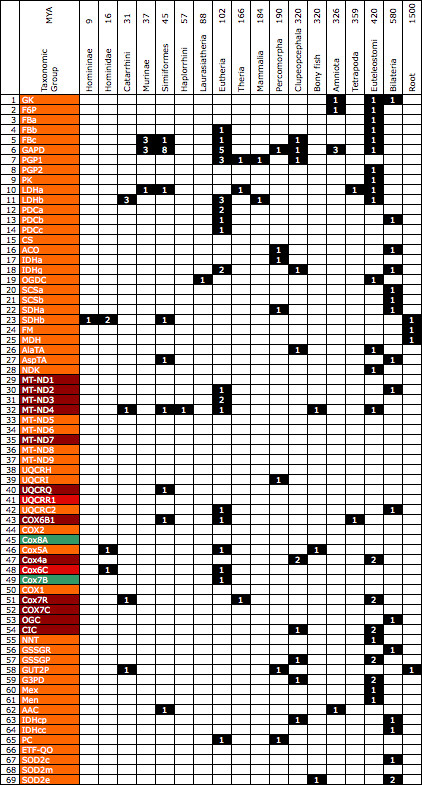
Matrix of inferred gene duplications in the 69 GSIS genes. Events are taken from the Ensembl gene tree displays and binned according to the taxonomic and date information given there. Bins with one or more inferred duplication are shaded, and numbers of inferred duplications at a given taxonomic level are given. These values were included in the calculation of the cluster diagram in Figure 4.